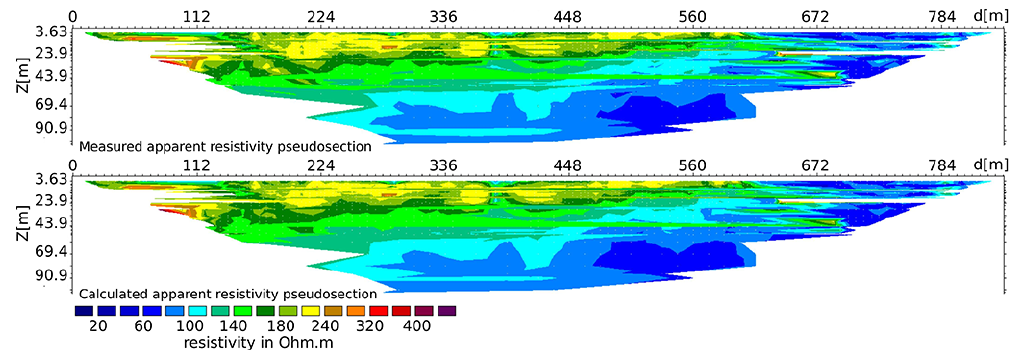
Figure A4. Apparent resistivity pseudosections. Measured (top) and obtained from inversion (bottom) apparent resistivity pseudosections along L1 profile. Two VESs were carried out using a Schlumberger configuration approximately 100m on the eastern and western sides of the San Ramón fault scarp observed in that area.